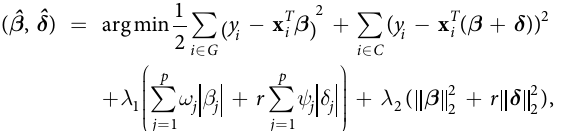
p are discrepancy parameters of G, p are discrepancy parameters of C. Here β represents a baseline effect that is shared across datasets. Formulations 1 and 2 are two different ways to model discrepancies between datasets. However, the two models are potentially interchangeable. More specifically, denote as β 1 the β in Formulation 1 and β 2 the β in Formulation 2. Then one can show that β 1 = β 2 + δ G and δ = δ C − δ G . We will restrict most of our attention to Formulation 1 since fewer parameters need to be estimated and fitted models are generally more stable as a result especially when sample size is small.